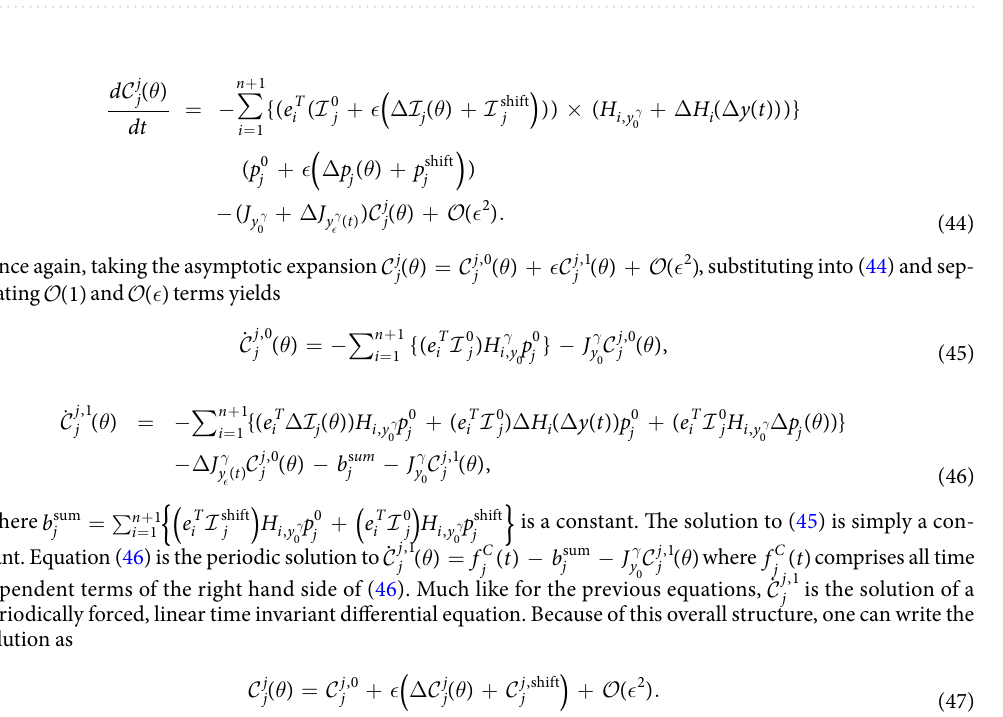
Figure 11. Summary of the linear relationships between the terms of the right hand side of (44) and the external forcing g ( t ). To leading order ϵ , The periodic orbit = + Δ γ γ linear system represented in panel A. The leading order ϵ time-varying components of the function p j and  result from the linear relationships represented in panels B and C, respectively. Note that function of Δ y ( t ). Any term that does not have explicit dependence on t in the above figure is